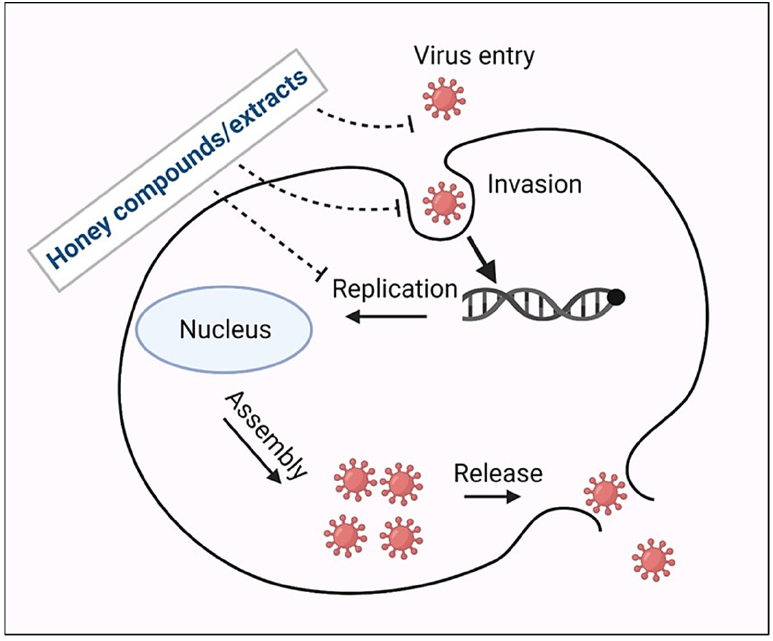
Figure 4. Honey and its components g eneral mode of action against viruses.